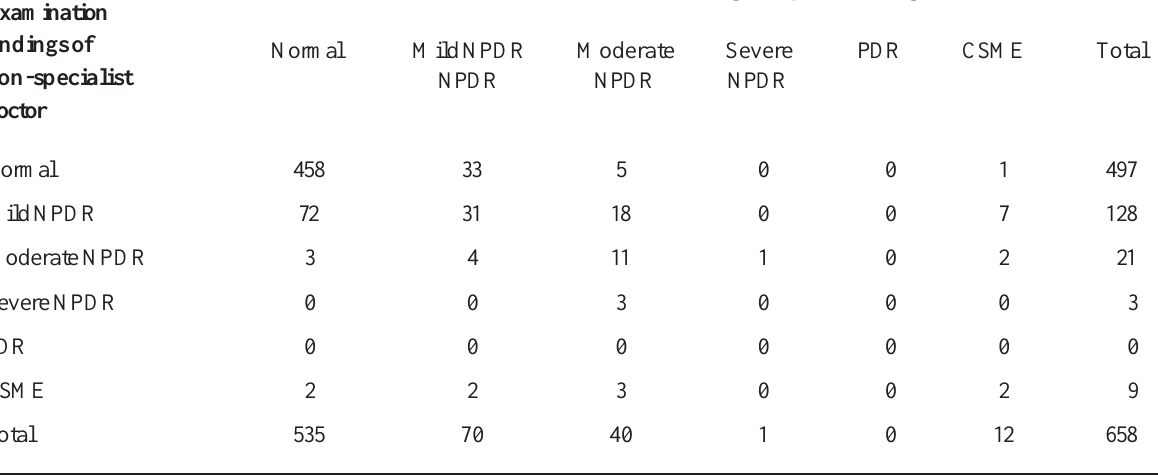
Table 3. The agreement of different types of diabetic retinopathy on fundus examination by